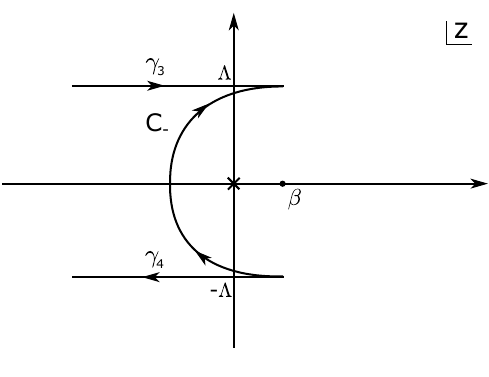
Figure 9 . Contour deformation for G −